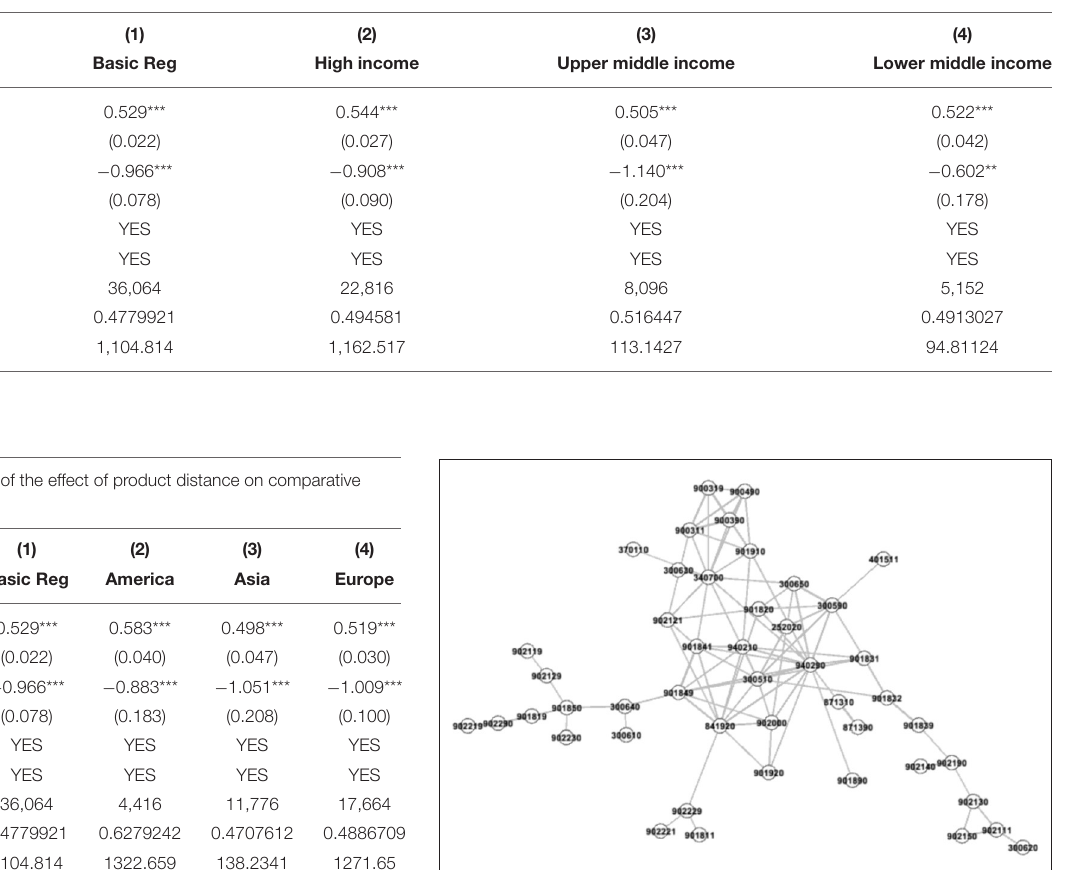
TABLE 3 | Model estimates of the effect of product distance on comparative advantage by income level.